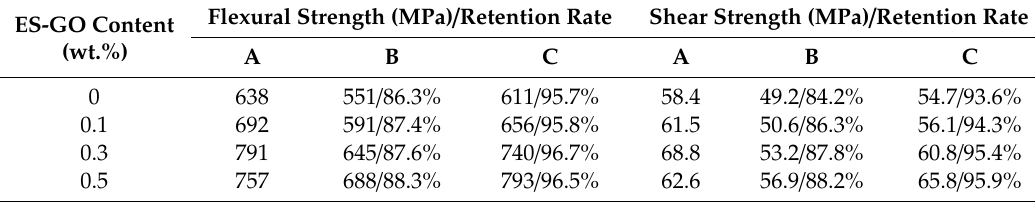
Table 2. Properties of the